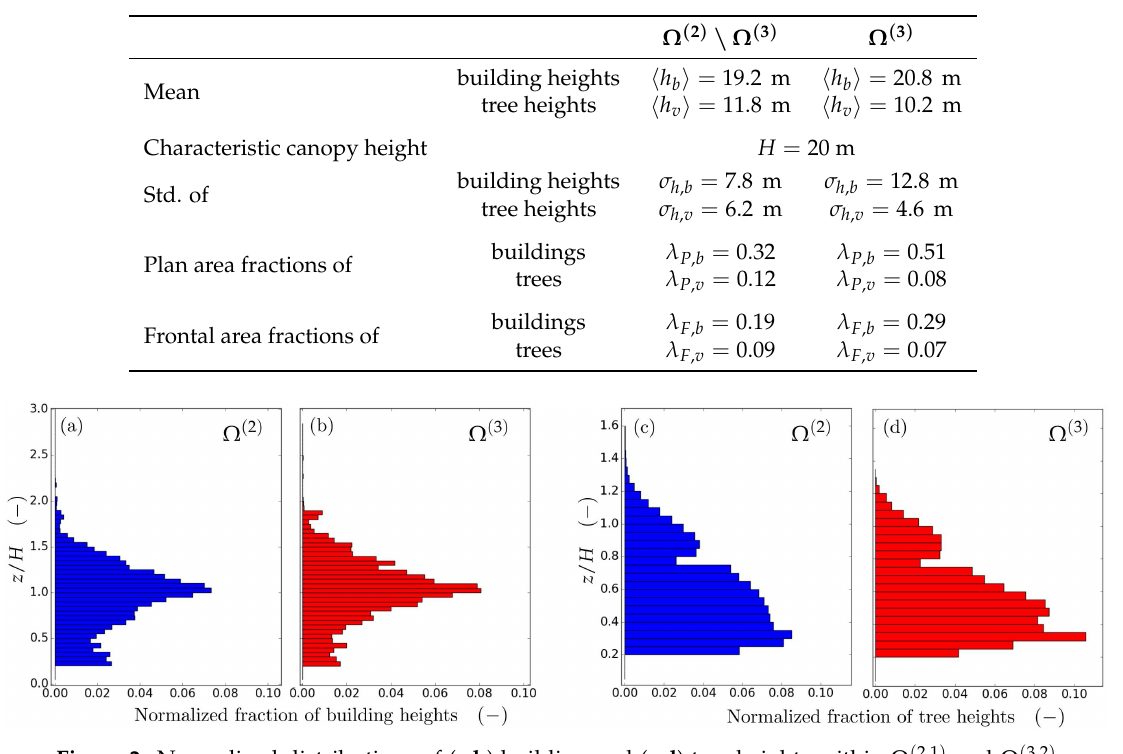
Table 2. Summary of morphometric statistics for the urban area: Separate values are listed for the area within Ω ( 2 ) but outside of Ω ( 3 ) and within Ω ( 3 ) alone.